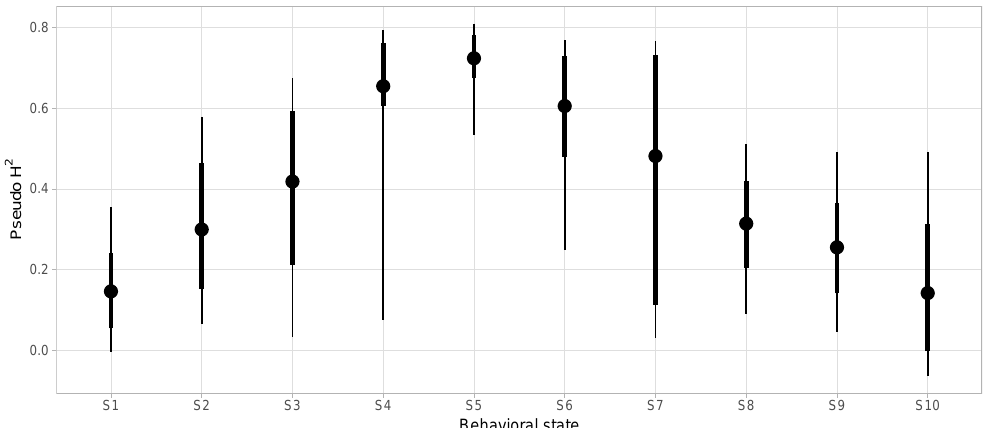
Figure 7. Genetic influences on the probability of being in a state in the studied population. Points represent posterior means, thick error bars, 66% central credible interval (roughly equivalent to 1 standard error), and thin error bars, 95% central credible intervals. See Methods for definition of the pseudo-h2